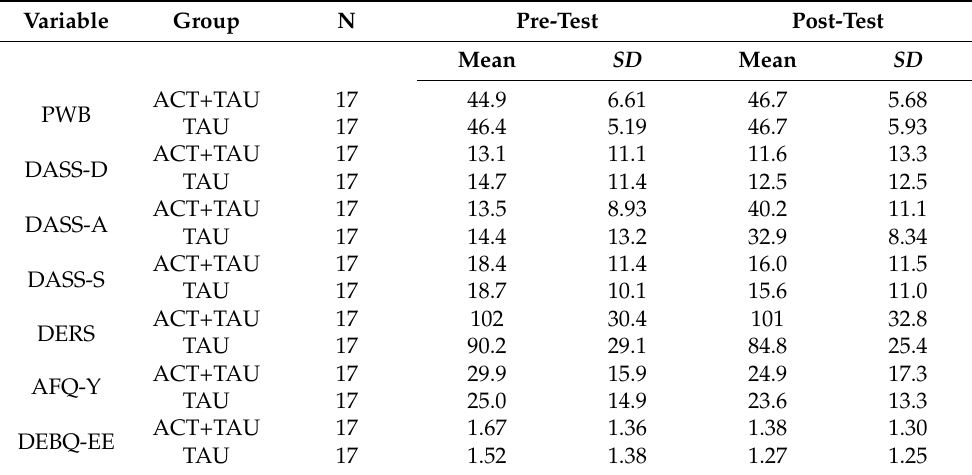
Table 2. Differences between ACT+TAU vs TAU only from pre-to-post intervention in all the outcome